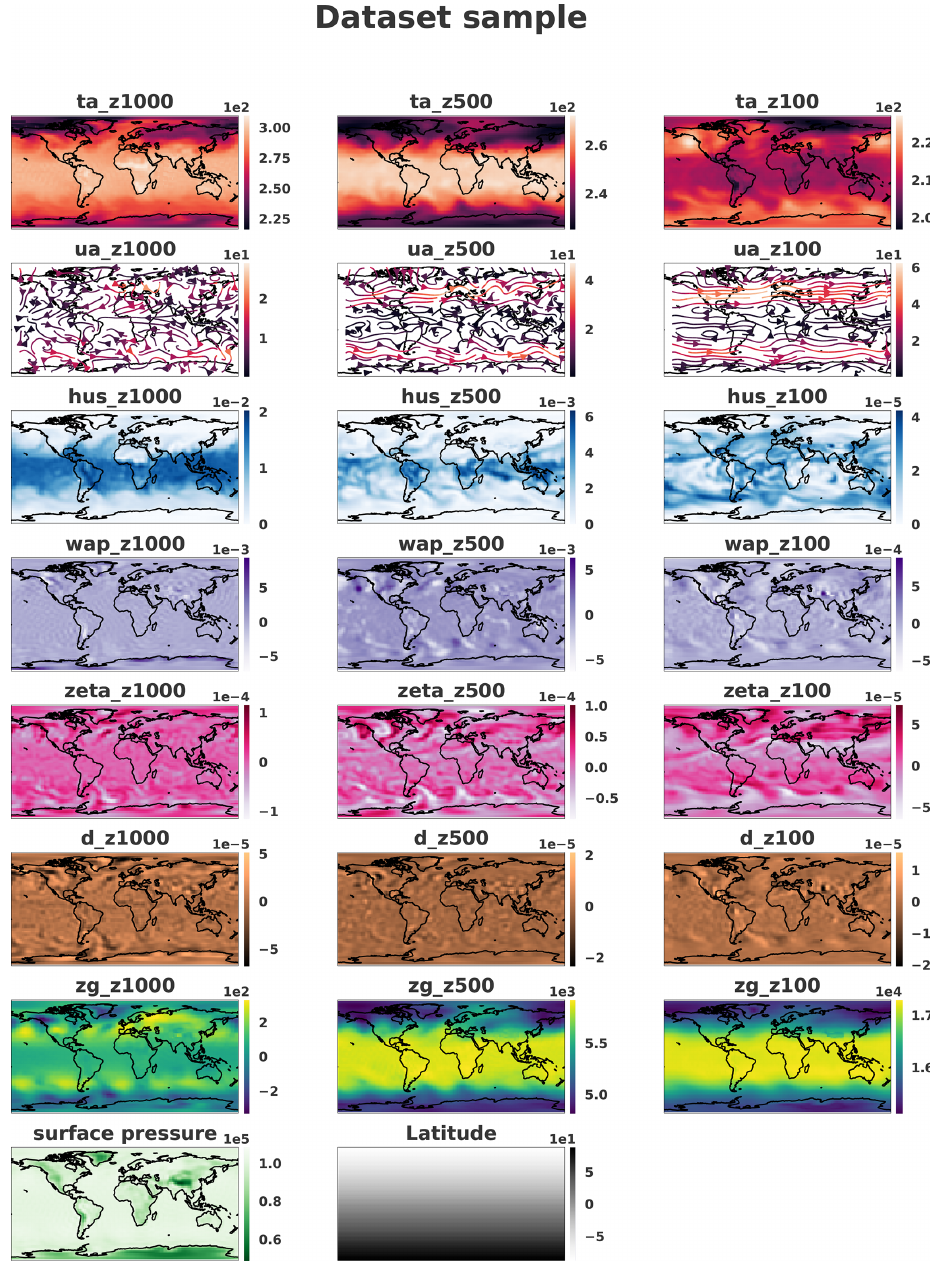
Figure 8. Sample on three different pressure levels (1000, 500 and 100hPa) taken from the dataset. The samples were horizontally transposed in order to have Europe at the center of the images. Coastlines were added a posteriori for readability. Units available in Table 2.